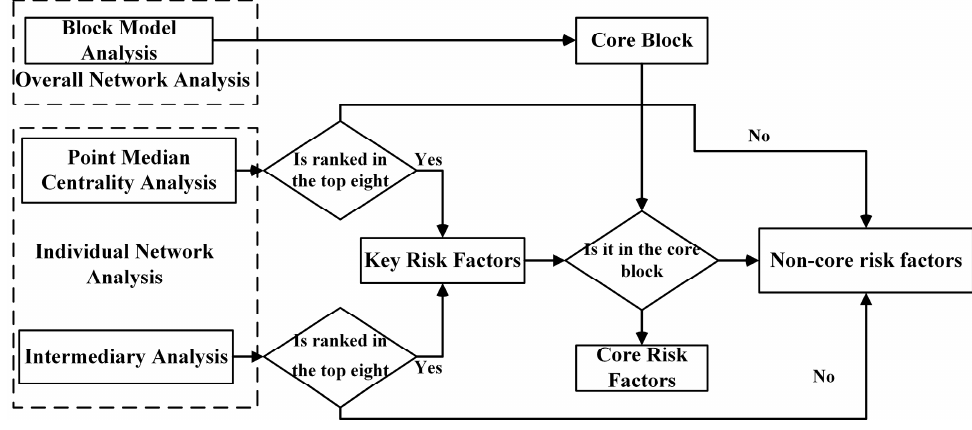
Figure 6. Core Risk Factor Identification Process.